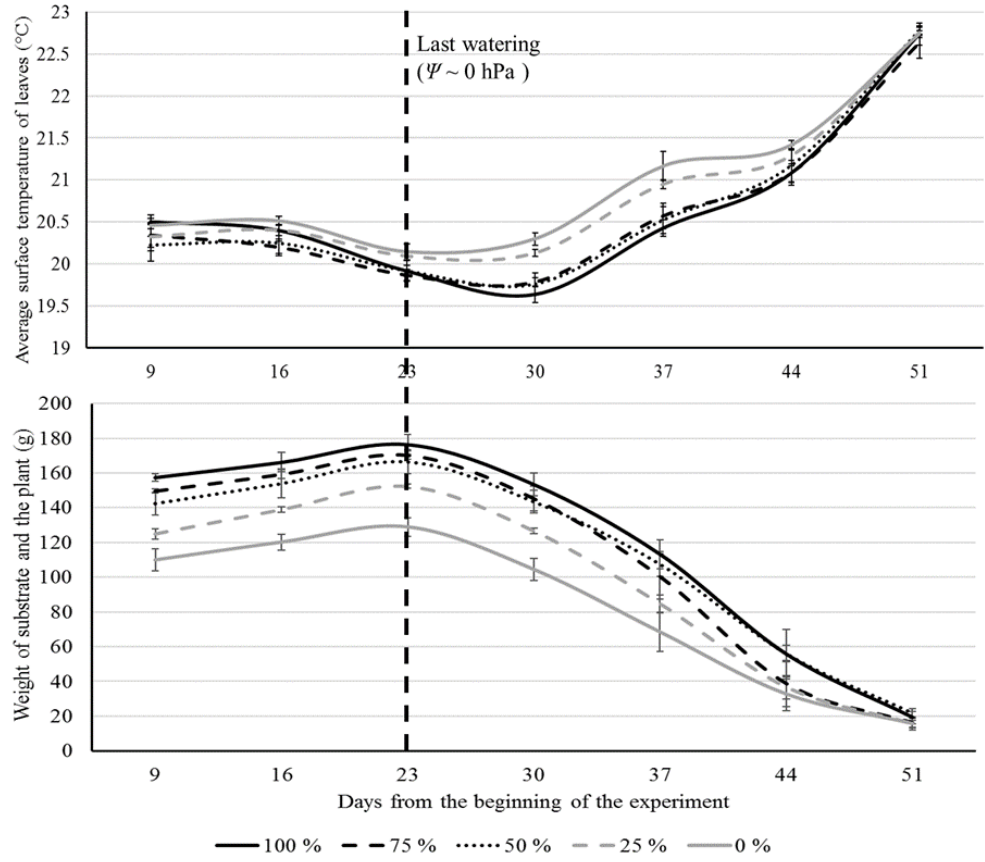
Figure 6. Results of Experiment 2 (sweet basil plants grown in the experimental mixtures of 0–100 % Sphagnum with peat, inside a growth chamber; severe drought was imposed on Day 23). Above: average leaf temperature derived by infrared (IR) imaging; below: pot weights. As a rule, the experimental replicates were weighed prior to the IR measurements, hence the pot weights illustrate the time course of drying. Error bars denote ± SD. n = 4.